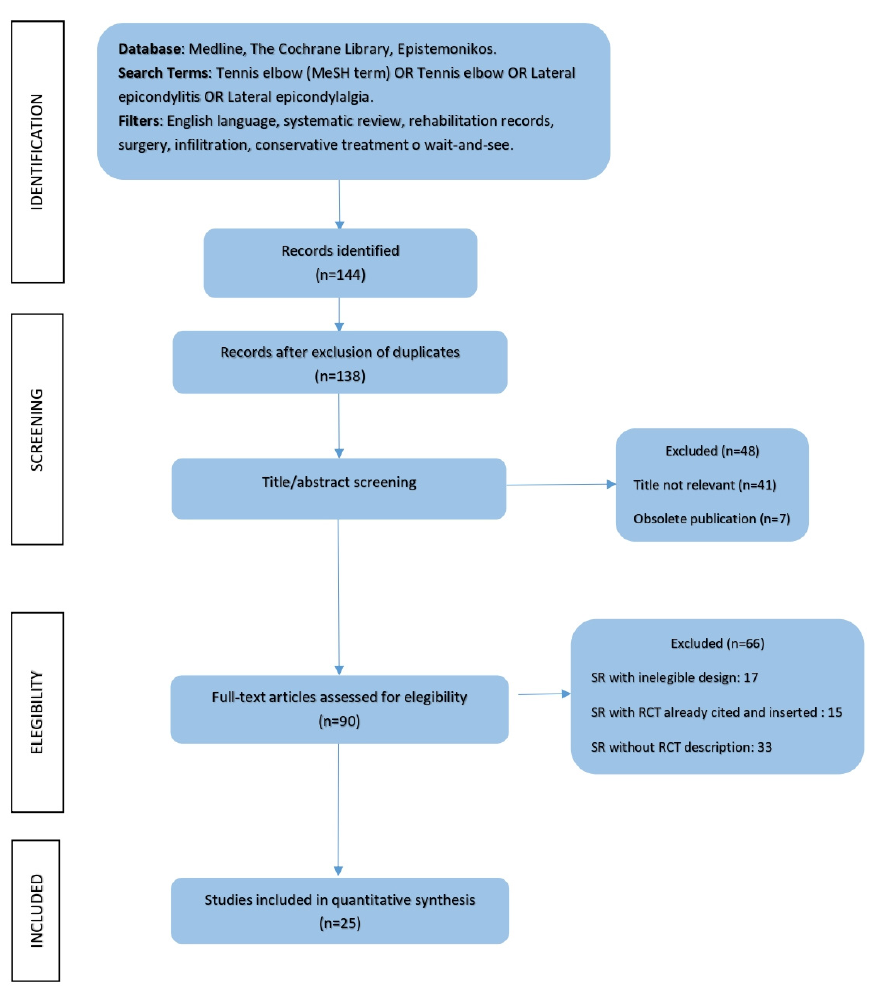
Figure 1. PRISMA flow diagram summarising the study selection process [16].